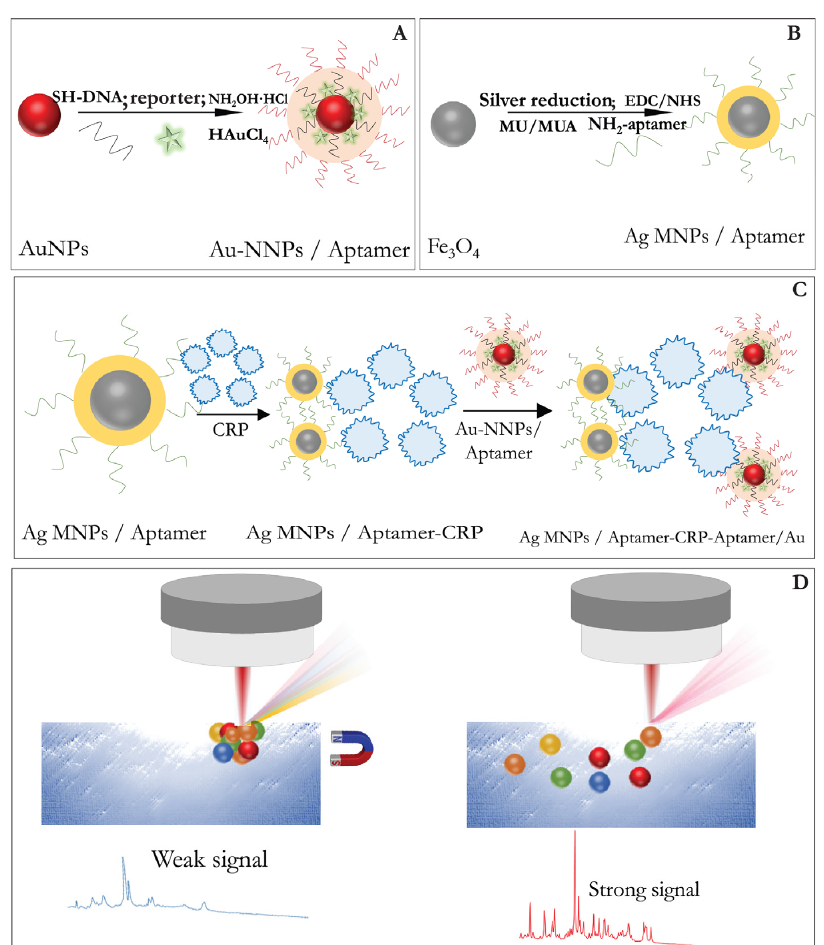
Figure 5. Schematic illustration of SERS aptasensor for CRP detection based on AgMNPs and Au-NNPs as SERS nanotag and magnetic capture substrate, respecitvely. The analysis included the following steps: ( A ) fabrication of SERS nanotag; ( B ) obtaining of AgMNPs modified with aptamer; ( C ) incubation of the CRP with Ag MNPs and SERS nanotag resulting in the formation of the sandwich complex AgMNPs–CRP–Au–NNPs; ( D ) magnetic separation of unbound SERS nanotag followed by SERS